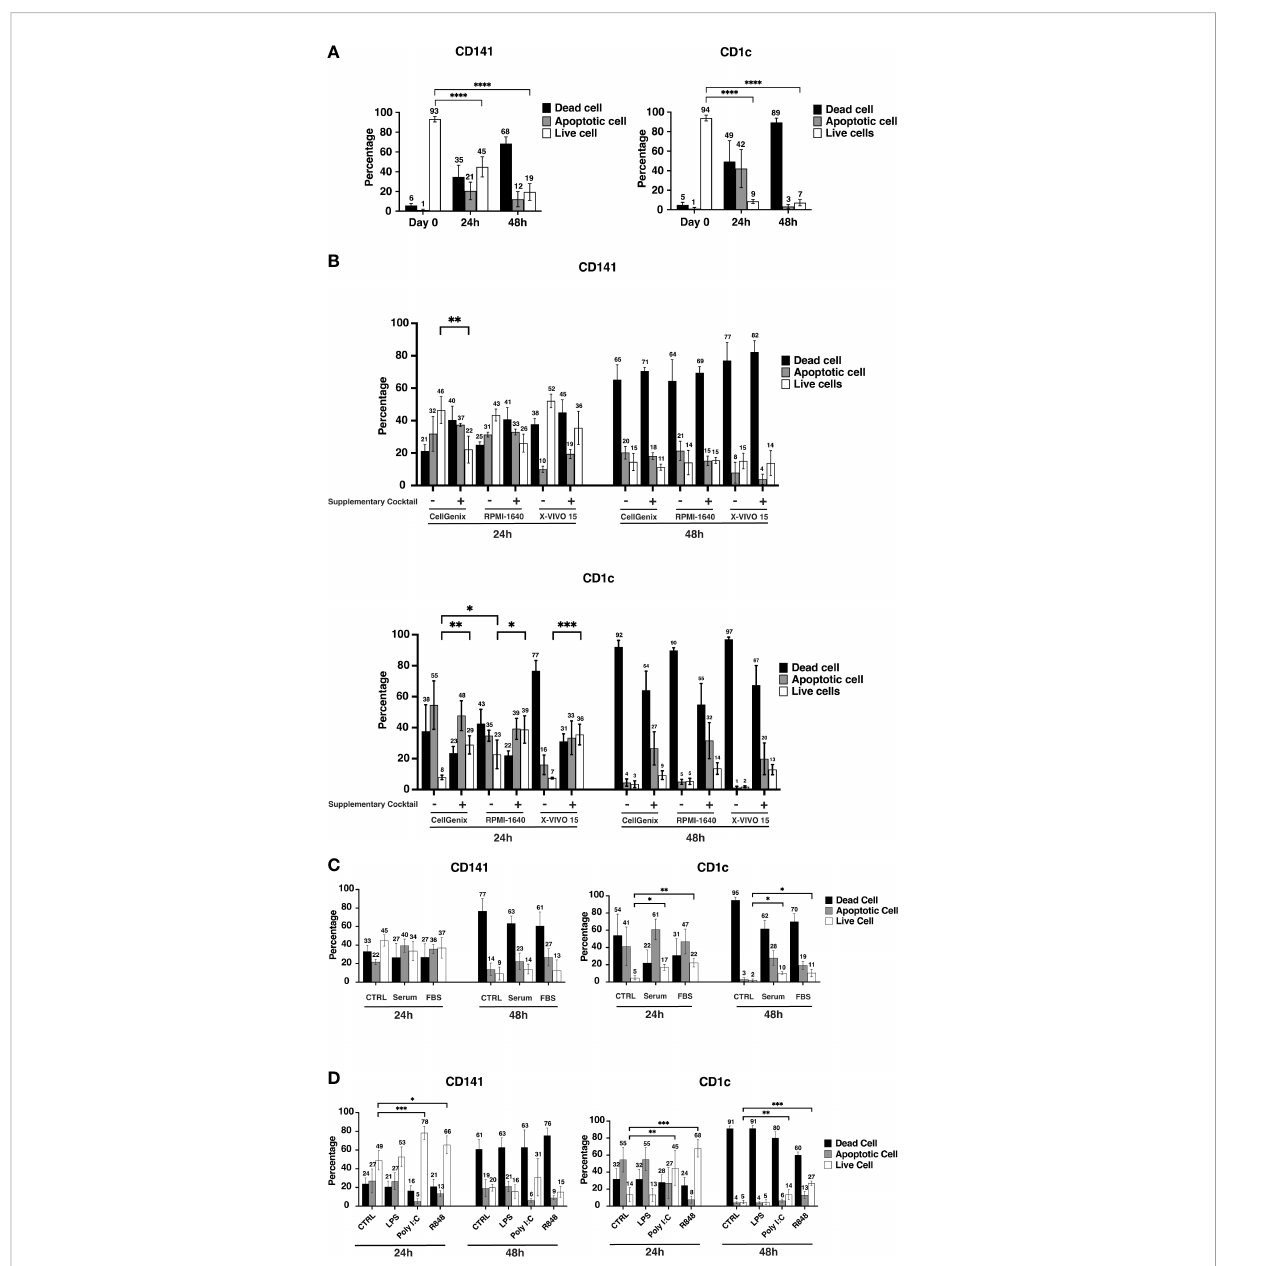
FIGURE 1 Conventional cell viability drops signi fi cantly within 24hrs. (A) After sorting, a portion of cells was stained with FITC Annexin V and Fixable Viability Stain 575V (FVS575V) and cells were analyzed by fl ow cytometry. Annexin V-/FVS575V- cells were considered as viable cells, Annexin V +/FVS575V- cells were considered as early apoptotic cells, and those cells which were Annexin V+/FVS575+ or only FVS575+ were considered as dead cells. Also, CD141+ cells (8000-10000 cells) and CD1c+ cells (30000 cells) were seeded in 96-well fl at-bottom plates and cells were incubated at 37°C. The percentage of viable cells, early apoptotic cells, and dead cells were analyzed by fl ow cytometry after Sorting (Day 0), 24hrs (24h) and 48hrs (48h). The graphs are representative of four independent biological replicates. (B) 8000-10000 CD141+ and 30000 CD1c+ cells were seeded in 96-well plates either in CellGenix or RPMI 1640 or X-VIVO15 in the presence or absence of supplementary cocktail ((Human AB-Serum (10%), HEPES (1%), 2-ME (50uM), L-Glutamine (2mM), Non-essential a.a (1x), Sodium Pyruvate (1mM)) for 24-48hrs. The graphs are representative of three independent biological replicates. (C) CD141+ and CD1c+ cells were cultured in serum-free CellGenix medium or in the CellGenix medium containing FBS (10%) or Human AB-Serum (10%) for 24hrs and 48hrs. Data are extracted from three independent biological replicates (D) CD141+ and CD1c+ cells were treated with either LPS (10 ng), or Poly I:C (12.5 µg/ml of High molecular weight (HMW) Poly I:C plus 12.5 µg/ml of Low molecular weight (LMW) Poly I:C), or R848 (2.5 µg/ml), or left untreated for 24hrs, 48hrs. Cells were analyzed using fl ow cytometry to measure the percentage of viable cells, early apoptotic cells, and dead cells. Cells were analyzed after 24hrs to 48hrs. Bar graphs show percentages of viable cells (white), early apoptotic (gray) cells, and late apoptotic/dead (black) cells at different time points. The graphs are representative of four independent biological replicates and mean values ± S.D. are shown. p values were calculated using two-way ANOVA with ****, p ≤ 0.0001; ***, p ≤ 0.001; **, p ≤ 0.01; *, p ≤